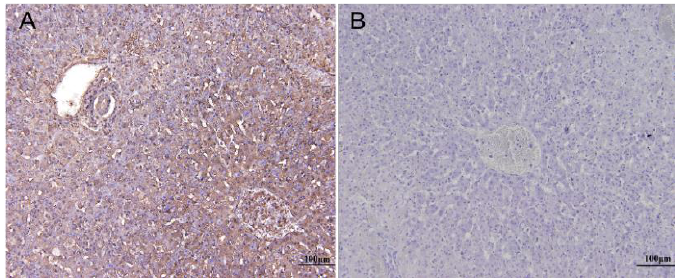
Figure 8. Detection of RHDV VP60 signals in the livers of the rabbits inoculated with the tissue homogenates of the dead Alpine musk deer by immunohistochemistry. Incubation with the primary antibodies against VP60 ( A ); incubation without the primary antibody as the control ( B ).